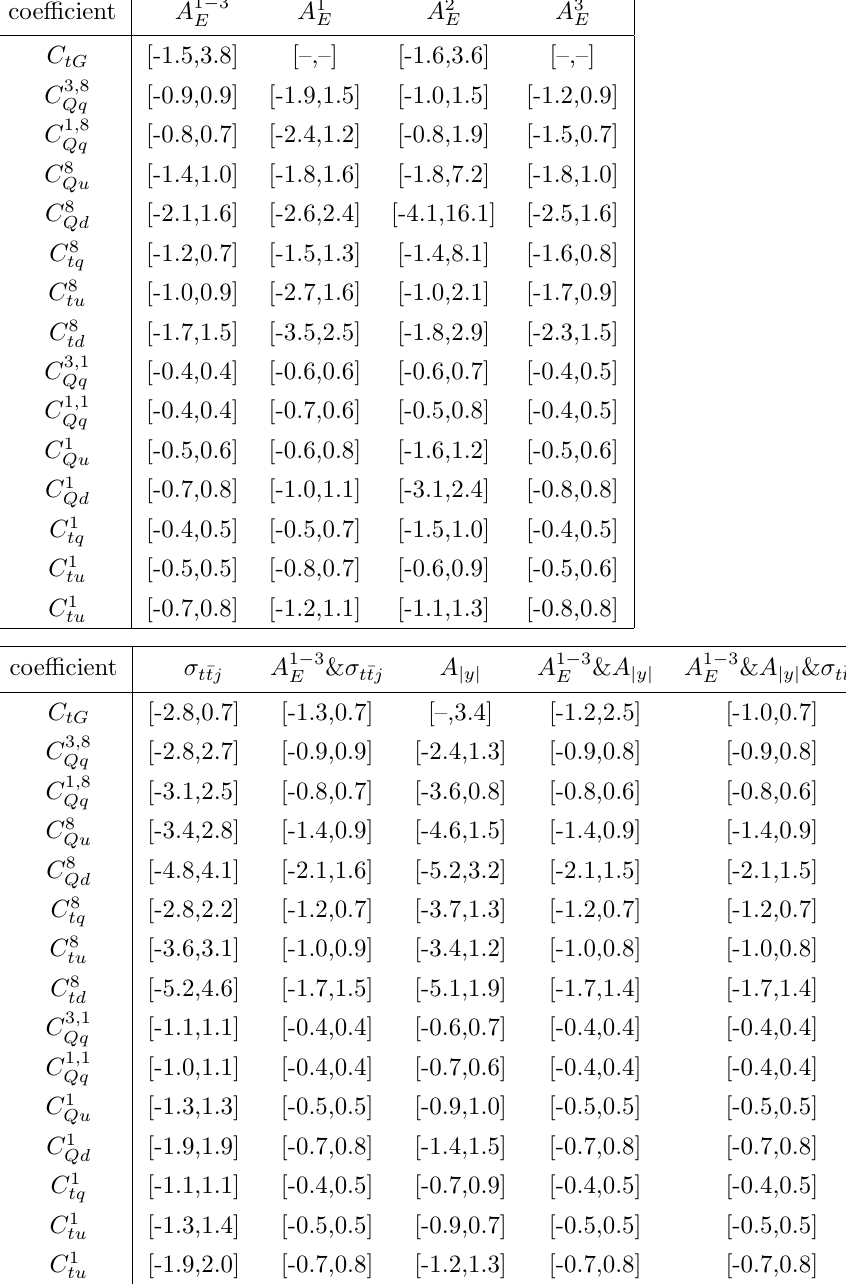
Table 4 . Expected 68% CL bounds on individual Wilson coe(cid:14)cients from (cid:12)ts to LHC measurements of the optimized energy asymmetry in three (cid:18) j bins A 1 cross section (cid:27) . All t (cid:22) tj observables are based on the boosted phase-space selection and a data t (cid:22) tj set of 139 fb (cid:0) 1 . We also show existing bounds from the rapidity asymmetry A measured during Run 2 [29], as well as combined (cid:12)ts to several observables. Empty spaces indicate that no limits could be found within C 2 [ (cid:0) 25 ; 25]. Bounds on C i are reported in units of TeV (cid:0) 2 .